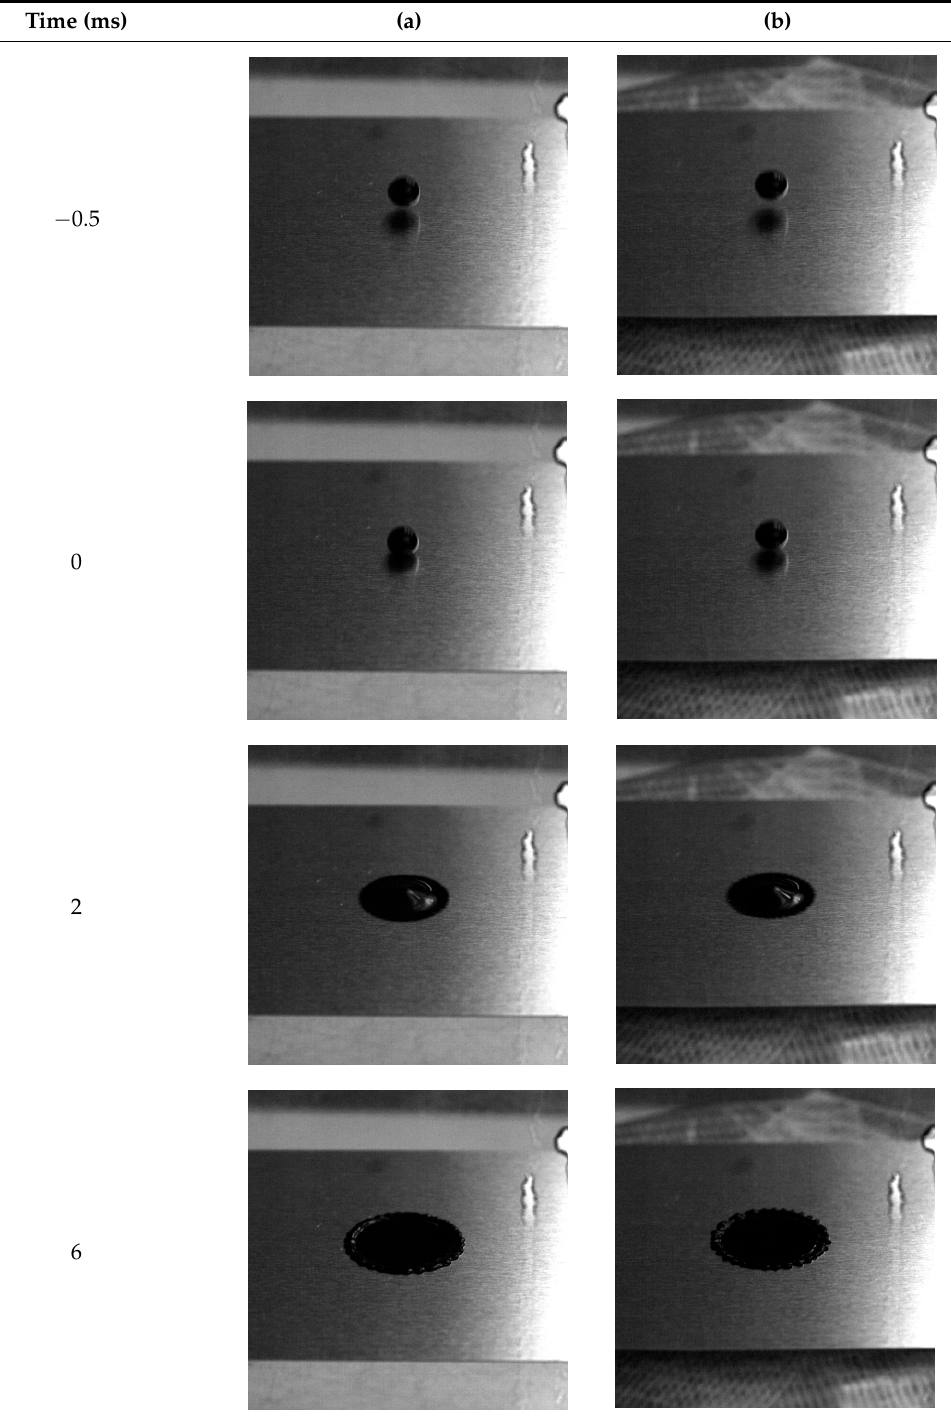
Table 2. Simultaneous high-speed images captured for the ( a ) unprocessed surface, ( b ) unprocessed surface with a magnetic field (72 × 10 5 A/m 2 ), ( c ) processed surface, and ( d ) processed surface with a magnetic field (72 × 10 5 A/m 2 ).